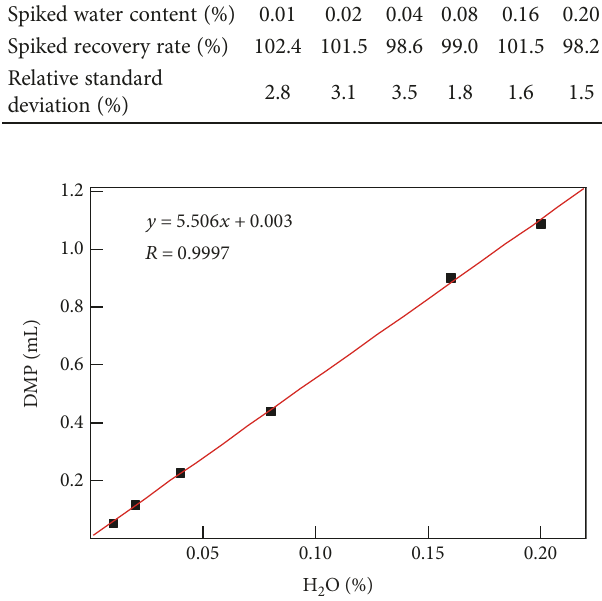
Figure 2: Linear regression equation of determining the spiked water